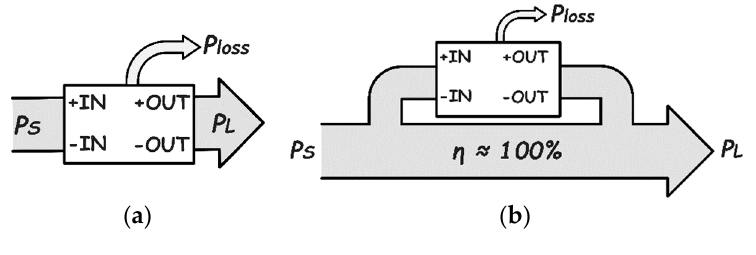
Figure 9. Power flow diagram: ( a ) FPP; ( b ) PPP.